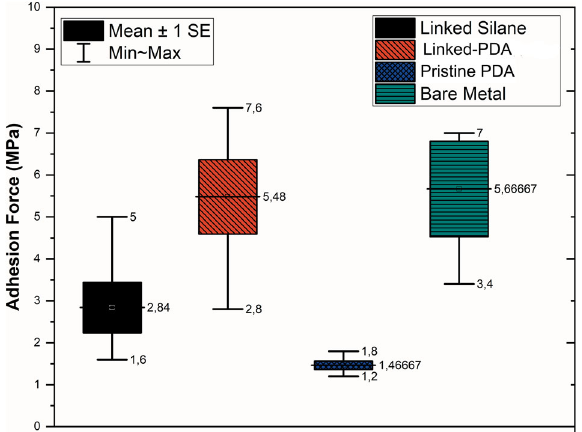
Fig. 9 Adhesion strengths chitosan coatings on various interstitial layers coated (black and blue), linked (red) bare (green) Ni-free stainless